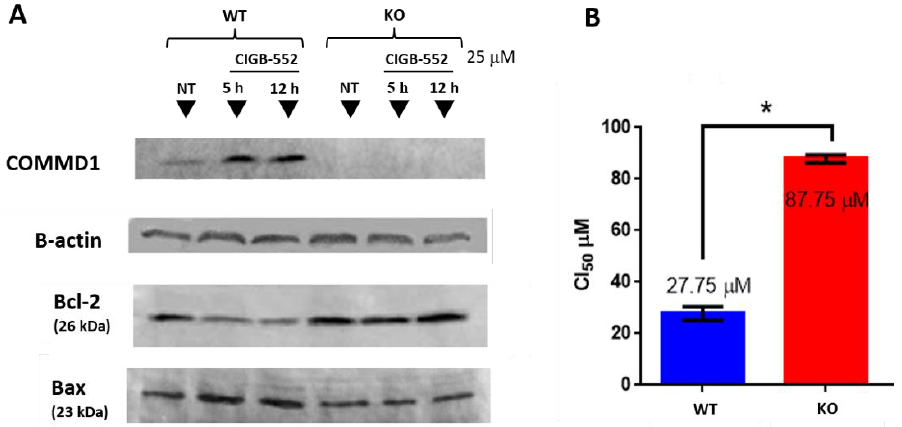
Figure 4. Generation of the H460 COMMD1 KO cell line. ( A ) H460 WT and KO cell lines treated with CIGB-552 (25 µ M) for indicated times and COMMD1, Bcl-2 and Bax were determined by Western blot analysis. Actin was used as a control for protein loading ( B ) CIGB-552 was added to 10,000 cells (0–200 µ M) and incubated for 48 h. Cell viability was determined by sulforhodamine B sodium salt assay and the IC50 values were calculated. Data presented as the mean ± SD. * p < 0.05.